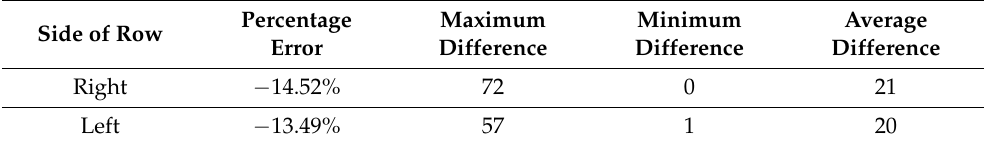
Table 2. Fruit flower cluster count from right side of row. which is similar to the result for the left side, which is − 13.49%. The minimum difference